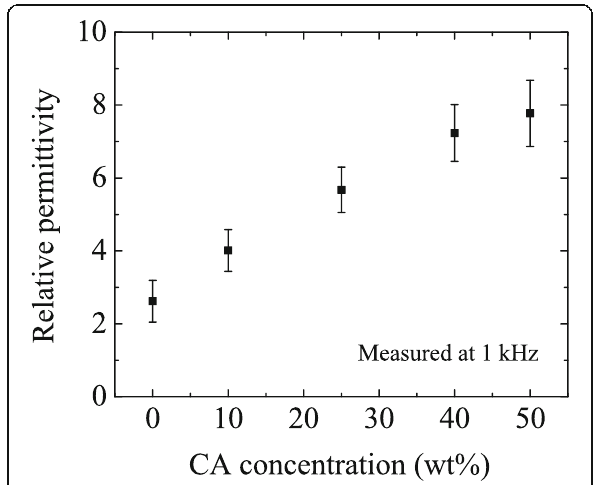
Fig. 2 Plot of the relative permittivity of the prepared devices versus CA concentration. The permittivity was almost constant in the 10 – 10 5 Hz frequency range, and the data taken at 1 kHz are plotted here